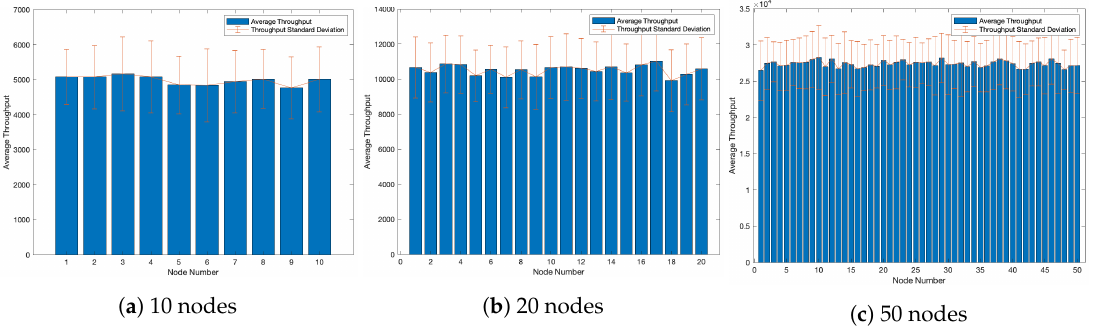
Figure 14. Average throughput, with standard deviation, where the broadcast interval is 10